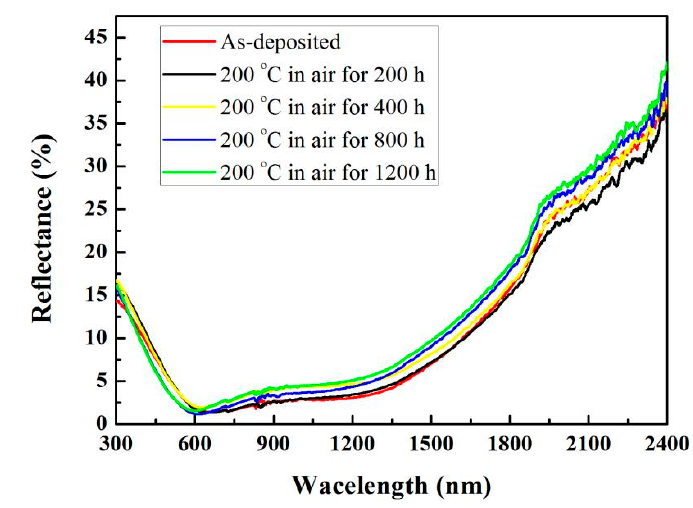
Figure 5. Reflectance of coating after heat treatment.